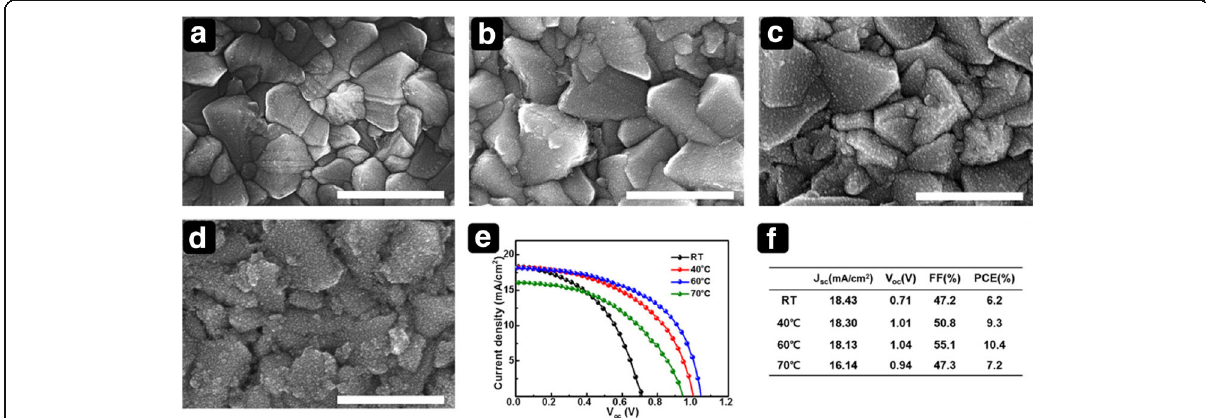
Fig. 4 Top-view SEM images of SnO 2 films electrodeposited at various bath temperatures. ( a ) RT, ( b ) 40 °C, e( c ) 60 °C, and ( d ) 70 °C. Corresponding photovoltaic performance: ( e ) J – V curves and ( f ) photovoltaic parameters of PSCs with electrodeposited SnO 2 ETL. Scale bar is 1 μ